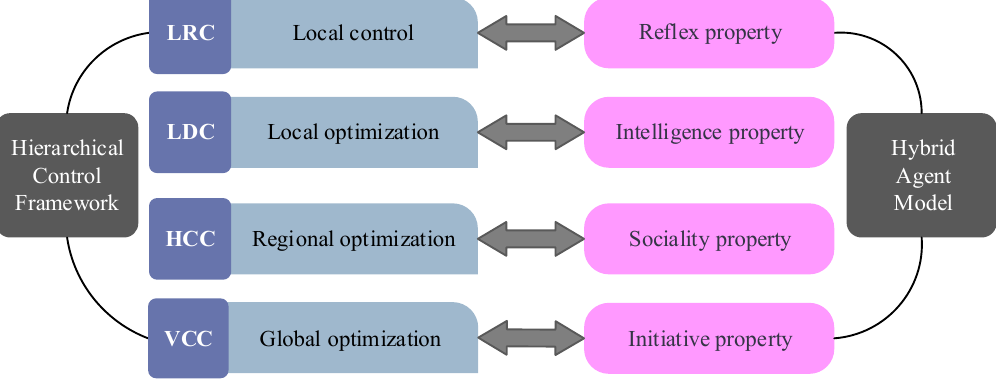
Figure 1. Relations between hybrid multi-agent control model (HAM) and hierarchical control framework (HCF). LRC: local reaction control; LDC: local decision control; HCC: horizontal cooperation control; and VCC: vertical cooperation